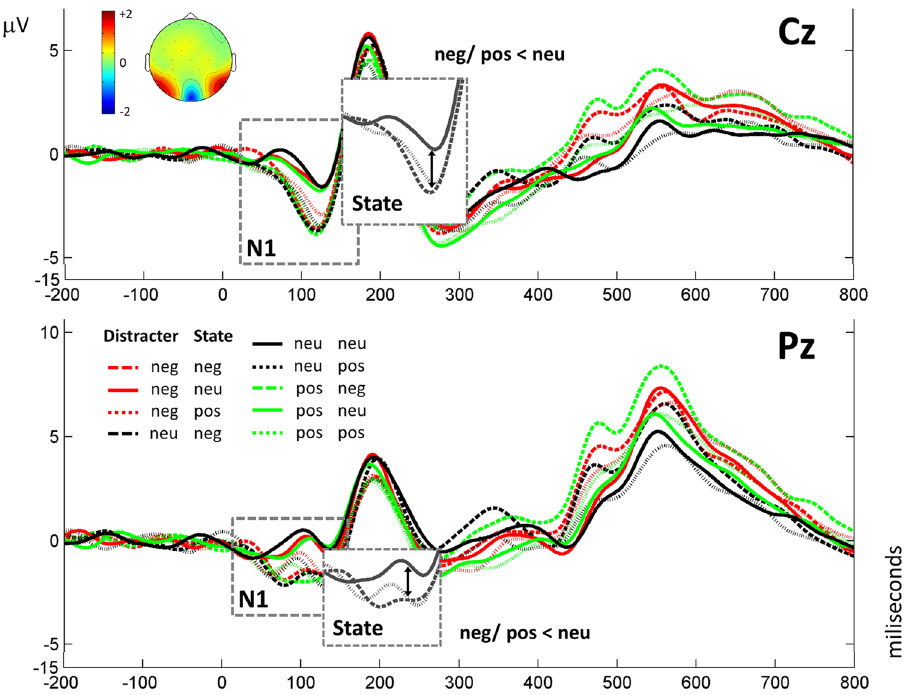
Figure 1. Results obtained for N1. Grand averages are presented at Cz and Pz, where results are clearly visible, depicting all conditions. Significant effects are shown in